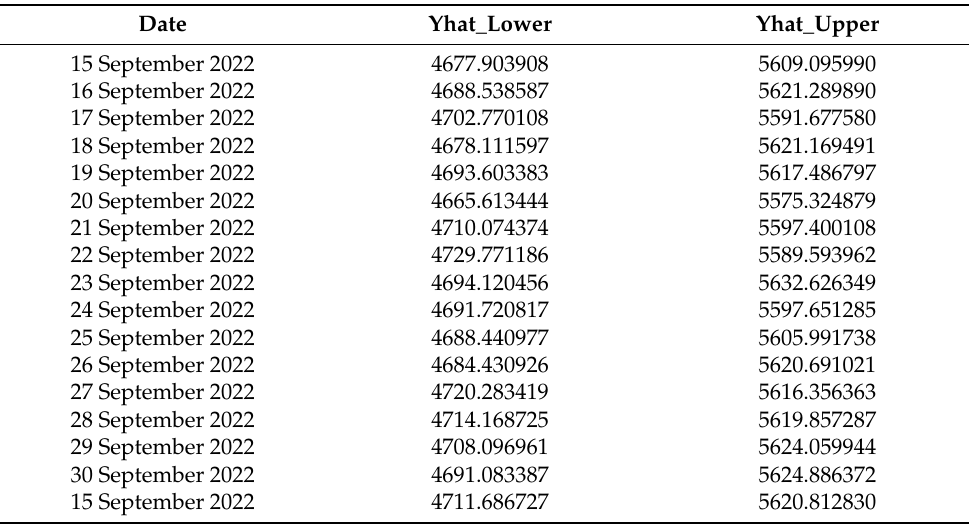
Figure 10. Future prices of the Ethereum cryptocurrency. Table 6. Results of the Ethereum data set for the last 15 days.